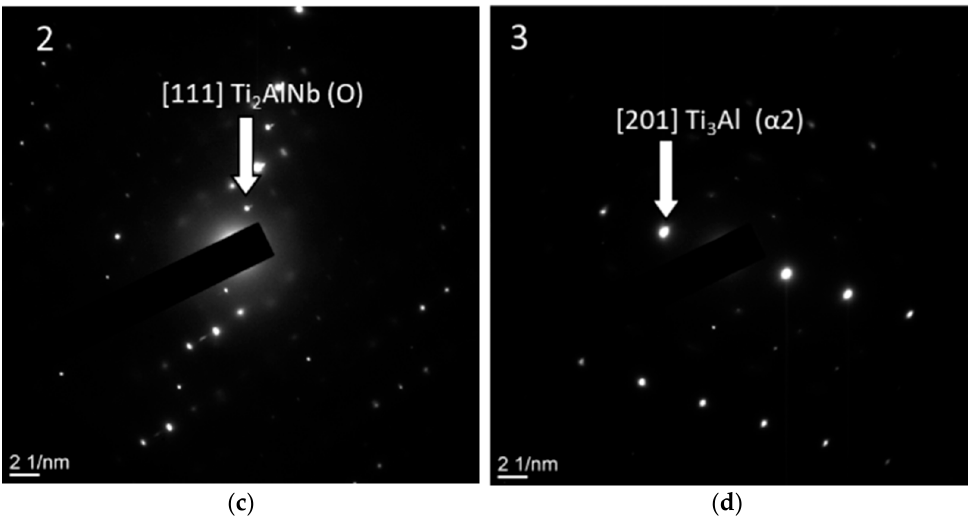
Figure 11. Fine structure of the alloy of the Ti-25Al25Nb at.% system: ( a ) bright field; ( b – d ) electron diffraction pattern from selected areas.